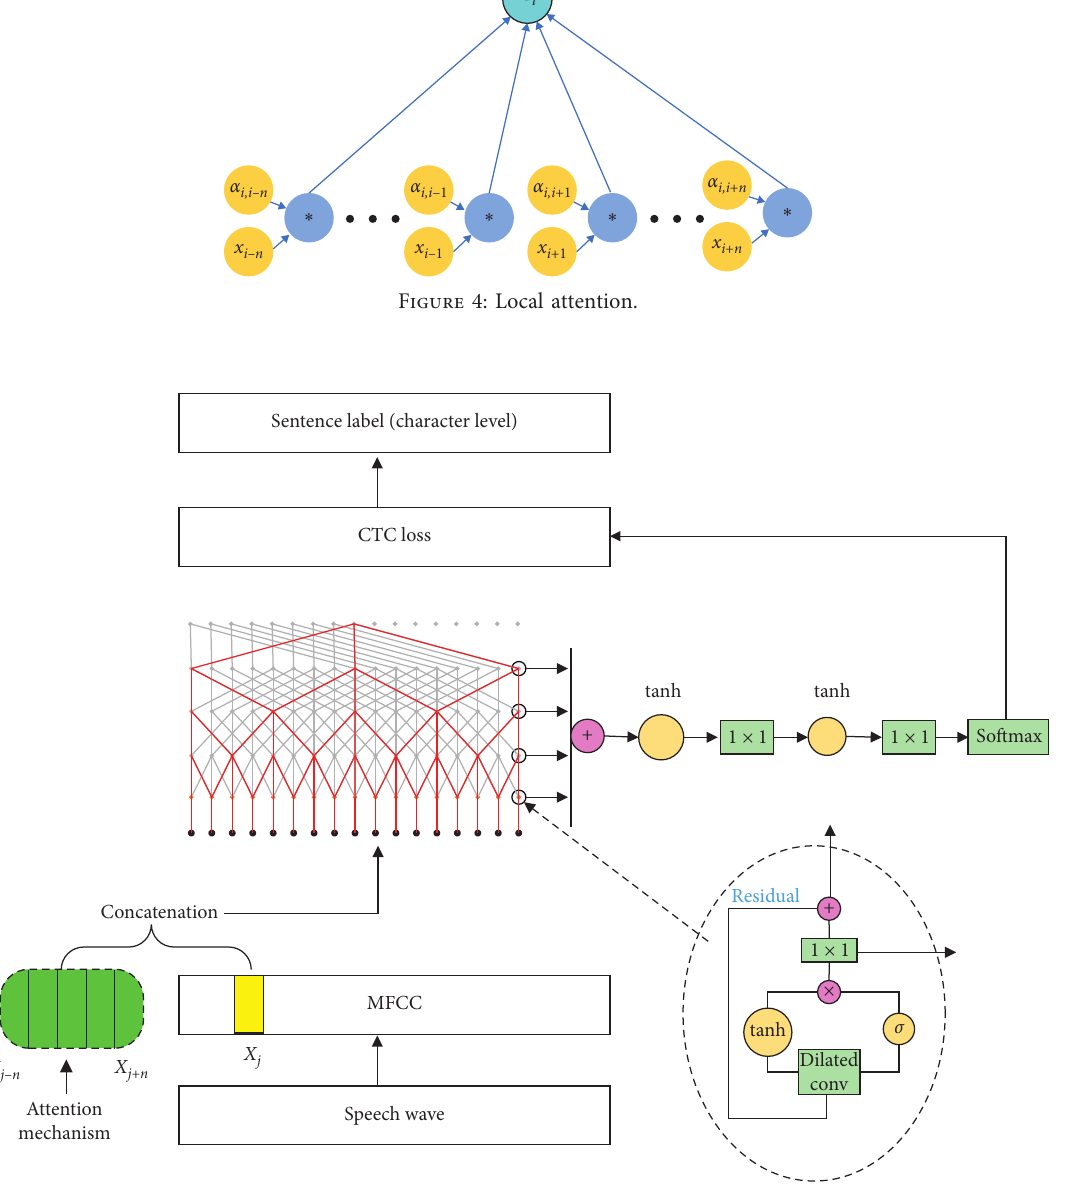
Figure 5: The architecture of attention-WaveNet-CTC.